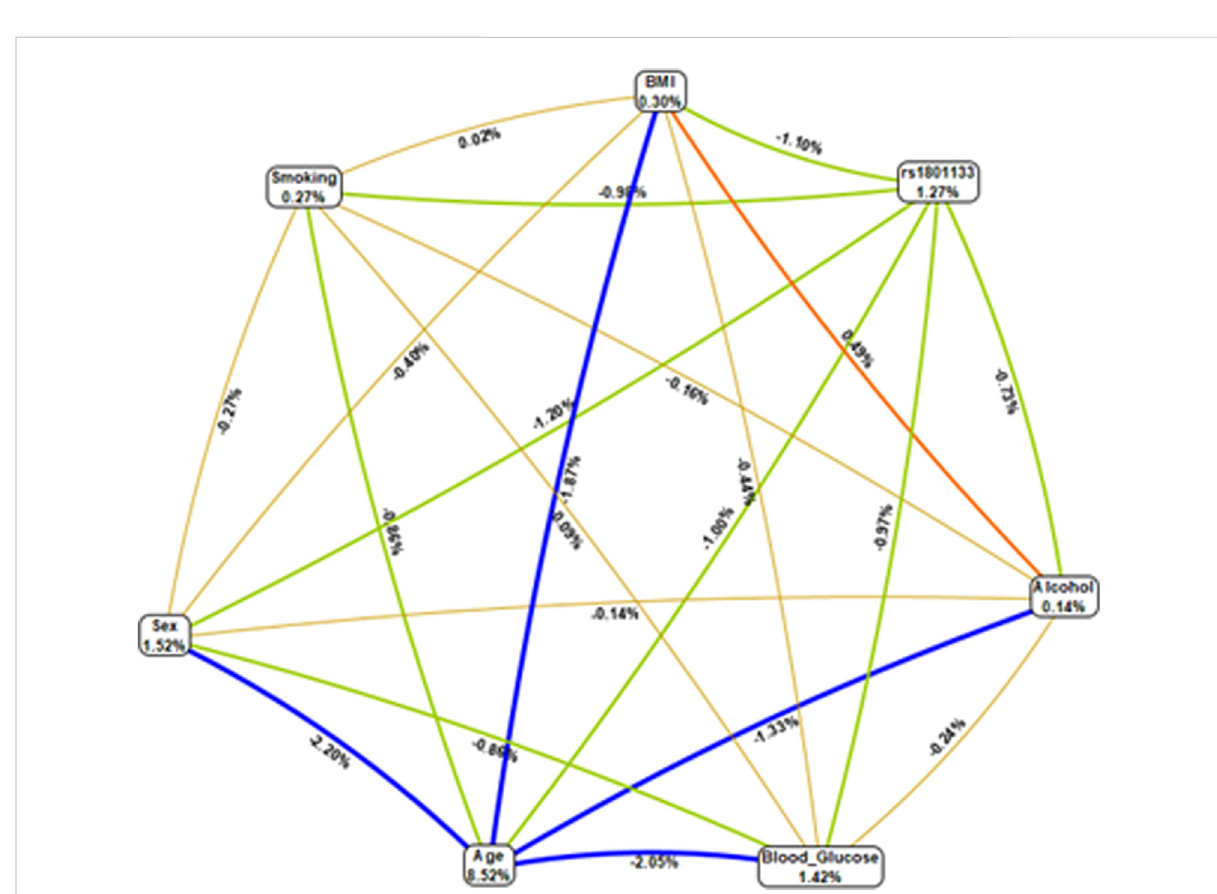
FIGURE 1 Multifactor dimensionality reduction combined attribute network demonstrating all possible interactions between rs1801133 and various environmental factors. Four different colours and various interactions between the genotypes of MTHFR (rs1801133) and selected variables (age, gender, smoking status, BMI, and blood glucose levels) were observed, and each colour represents a possible interaction. The width of the line indicates the strength of the interaction, whereas the thin lines represent weak interactions. Figures < 1 and thin lines represent weak interactions.Thestrongestinteractionsarerepresentedby fi gures ≥ 1andthicklines.Theimagewasgeneratedusingtheopen-sourceMDRsoftware package version